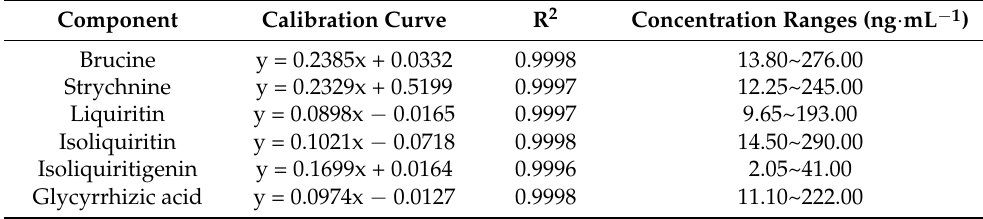
Table 1. Standard curves of 6 components.